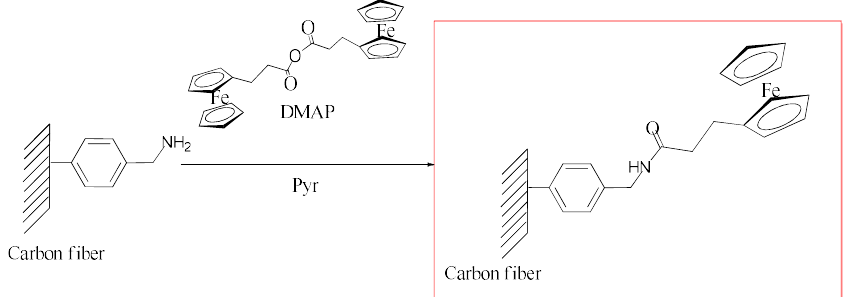
Figure 3. Reaction scheme for binding electrochemically active structure to the 4-(aminomethyl)benzene functions. Abbreviations: DMAP—4-dimethylaminopyridine; and Pyr—